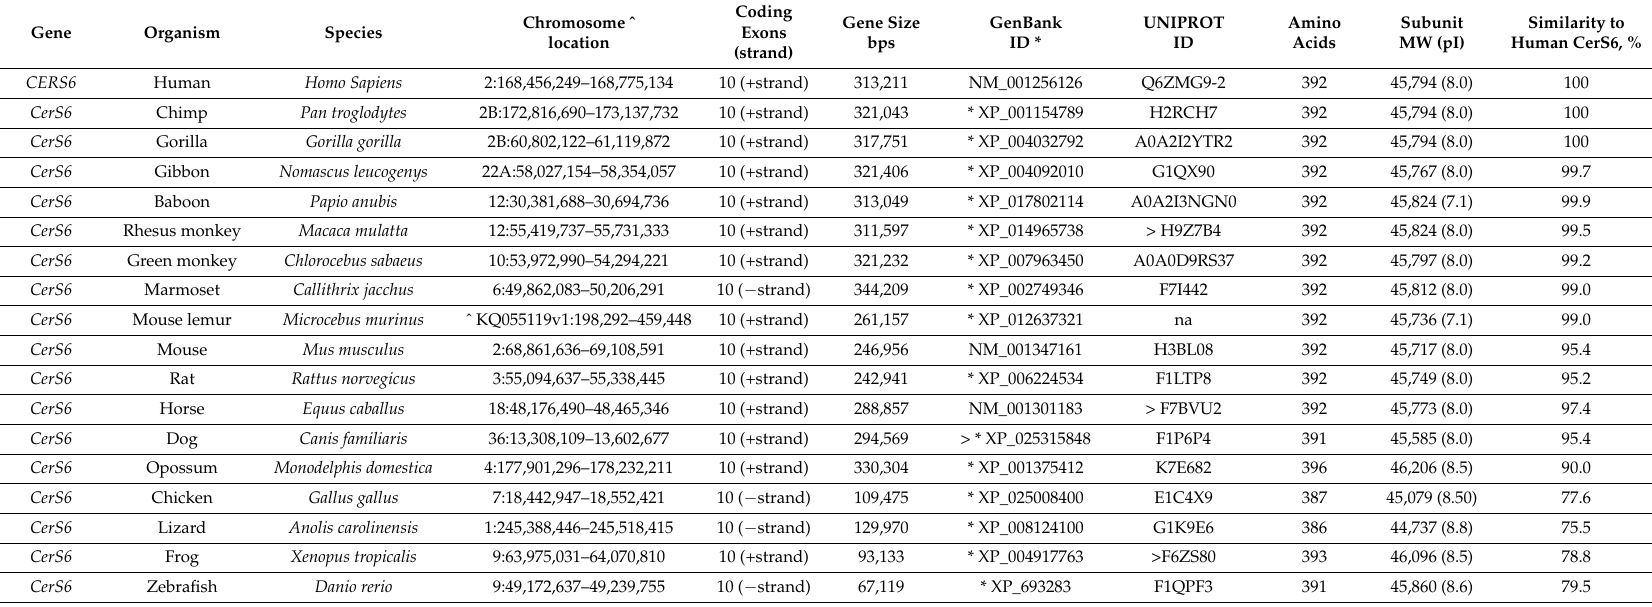
Table 1. Vertebrate CerS6 genes and